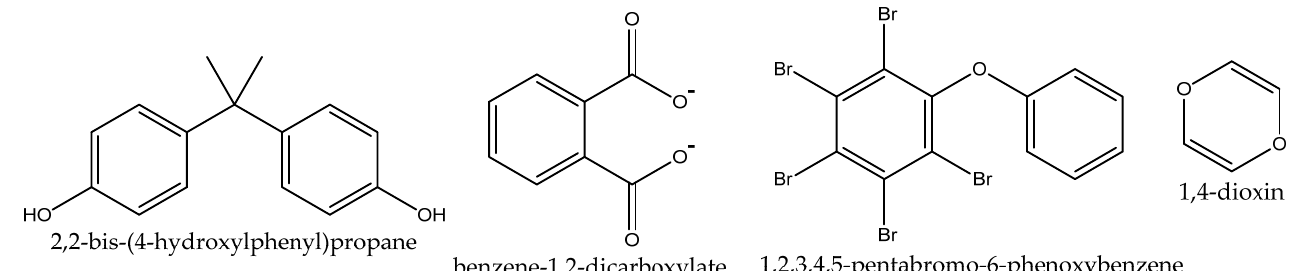
Figure 9. Example of endocrine-disrupting compounds.